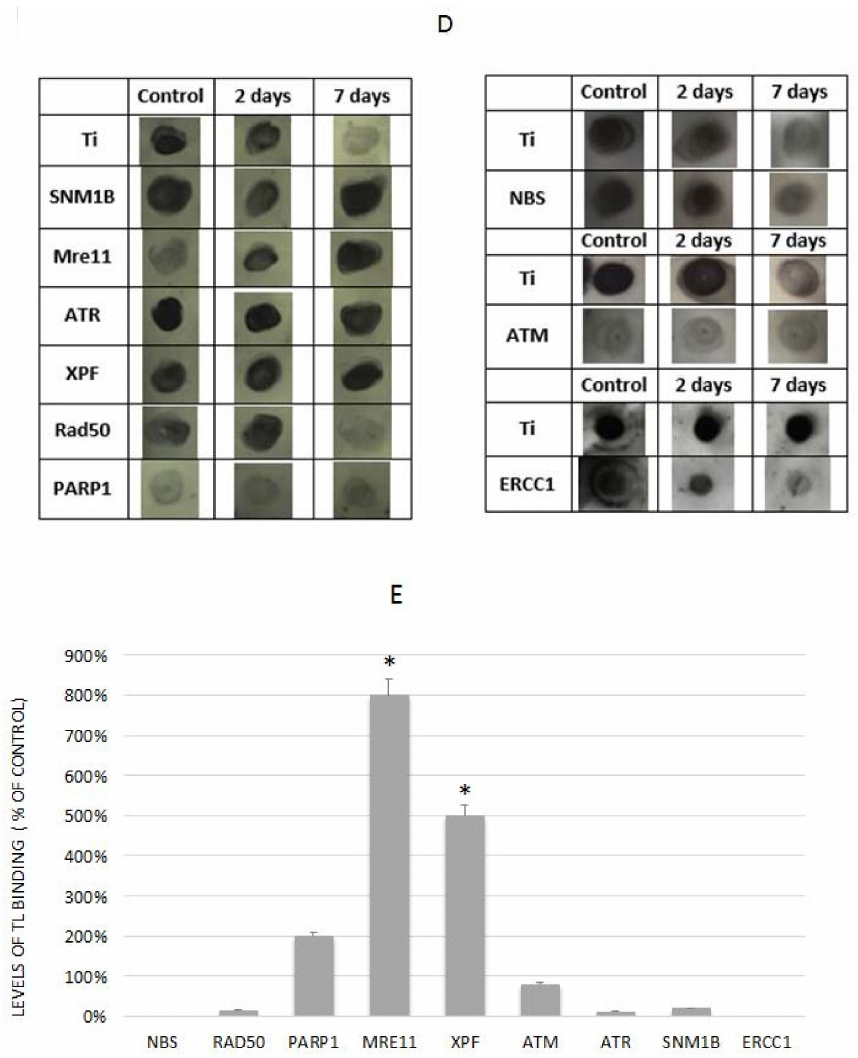
Figure 2. ChIP dot blot of all six Shelterin proteins, TRF1, TRF2, RAP1, POT1, TIN2 and TPP1, in three different cell lines. The upper part of each panel shows a representative dot blot and the lower represents three independent experiments. All cells were exposed to 25 mM EtOH for two days and subjected to the ChIP dot blot assay. Values indicate the signal intensity relative to the total input samples signals. ( A ) Primary hFF; ( B ) hFF-IM; ( C ) HepG2 cell line. * pV < 0.05 ** pV < 0.01. ( D ) The level of binding and the total cellular levels of TRF2 binding proteins to telomeres in hFF-IM cells assessed by ChIP dot blot. Examples of the various dot blots. ( E ) Quantitation of signal